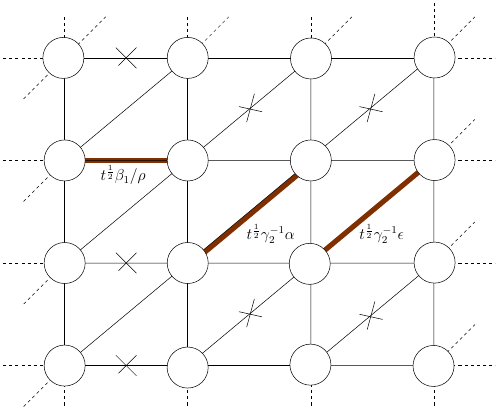
Figure 2 . We get rid of all the minimal punctures by giving vacuum expectation values to baryons. In every free trinion we give a vacuum expectation value to one of the baryons. The choice of the baryons is related to the (cid:13)ux and in general di(cid:11)erent choices lead to di(cid:11)erent theories in the IR. The baryons which do not receive a vev but are charged with same charge under the minimal puncture symmetry as the baryon which does receive vev, are (cid:13)ipped. In the diagrams the (cid:12)elds with a cross are the baryons which are (cid:13)ipped. In the picture the baryons which receive vacuum expectation value are weighed as t N 2 (cid:12) N =(cid:26) N , t N 2 (cid:13) N (cid:11) N , t N 2 (cid:13) N (cid:15) N . 1 2 2 the UV, k gauge groups cycle A and the other one cycle B. The UV model then has loops winding once around cycle A corresponding to puncture symmetries and k loops winding l times around each one of the cycles A and B, and l loops winding (cid:0) l times around cycle A and l times around cycle B. The (cid:13)ow initiated by closing the punctures preserves the symmetries not associated to the punctures and breaks symmetries associated to